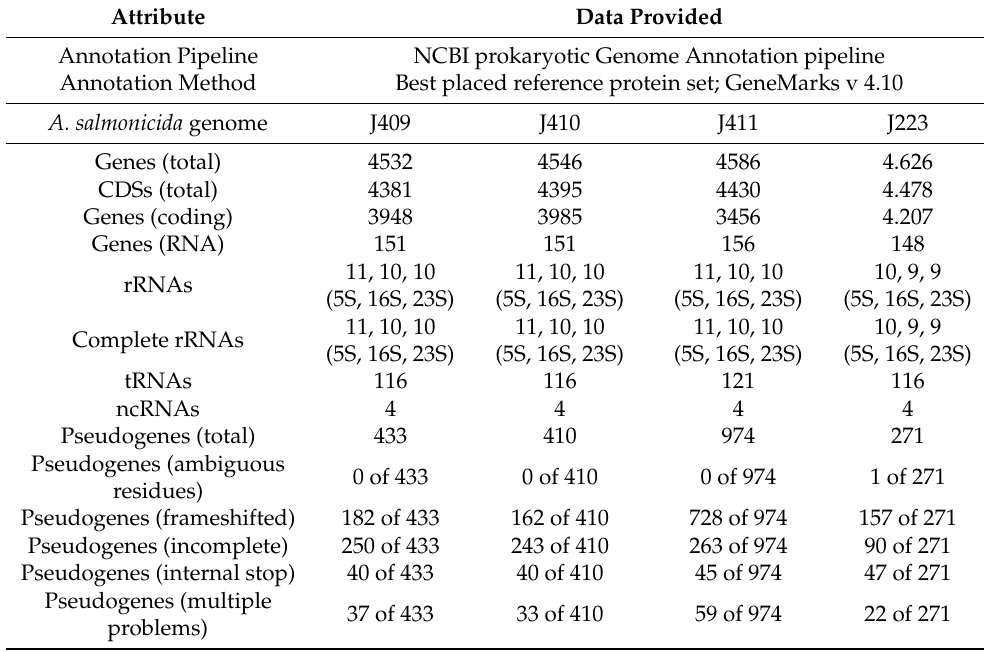
Table 3. NCBI Prokaryotic Genome Annotation Pipeline